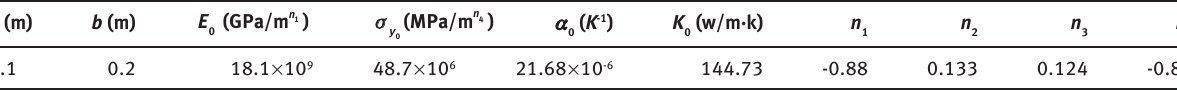
Table 1: Specific properties of thick-walled FG cylindrical vessel [24].